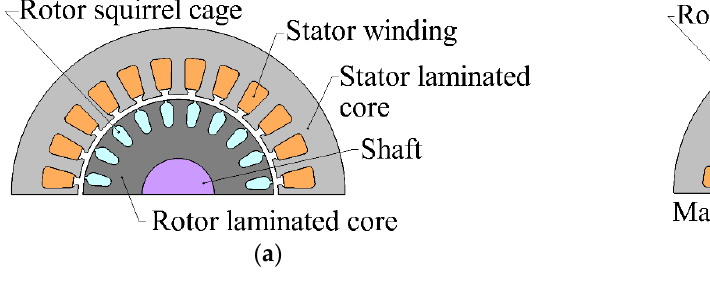
Figure 1. Motor sketches: ( a ) Induction motor (IM); ( b ) line-start permanent magnet synchronous motor (LSPMSM) [1].